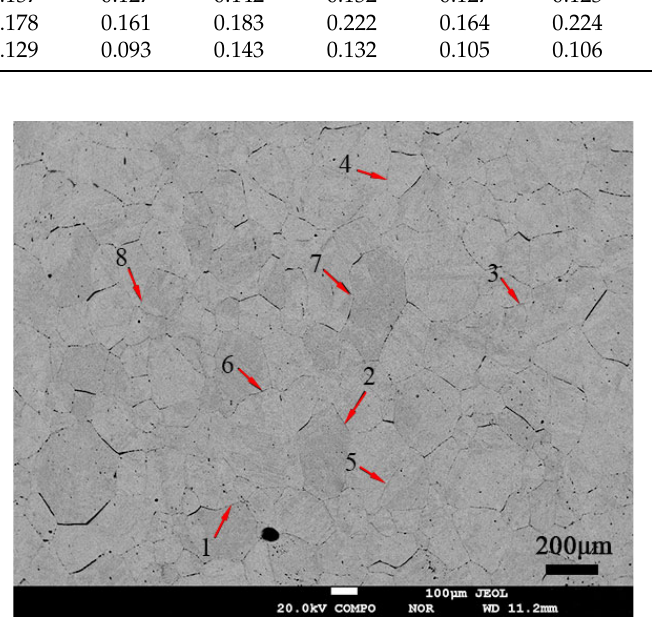
Figure 5. Spot scan by EPMA at grain boundary of steel 2.